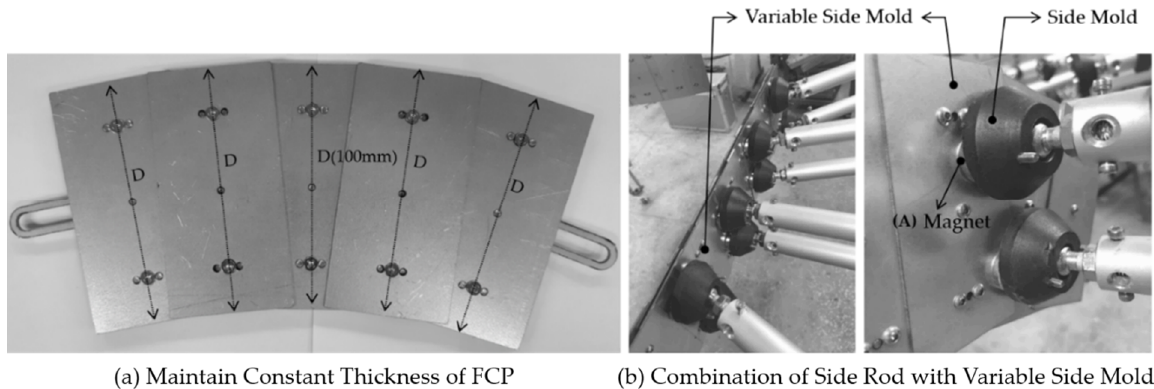
Figure 5. Variable side mold and side mold control equipment bonding